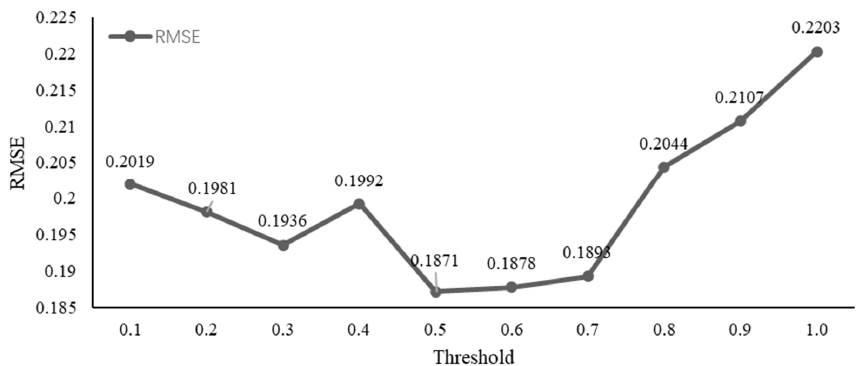
Figure 9. Variations in the root-mean-square error (RMSE) at different thresholds obtained through